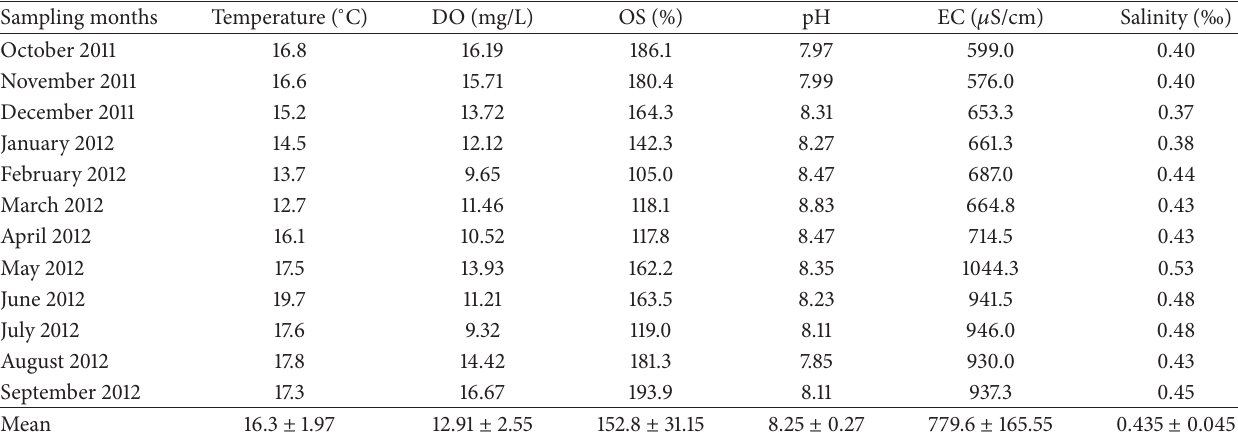
Table 1: Bulakbas¸ı water results obtained based on in situ